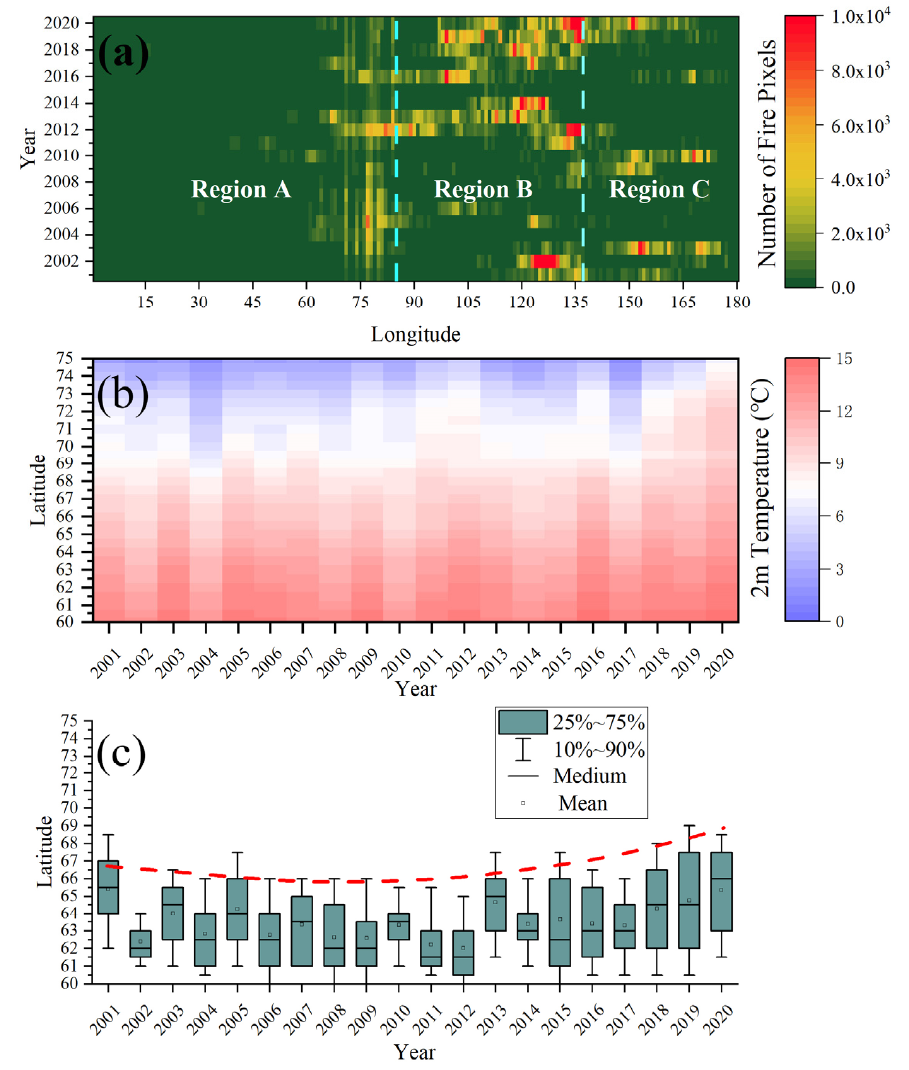
Figure 7. Summary trends in the spatial distribution of MCD14ML active fire pixels. ( a ) Longitude vs. time. ( b ) Latitude vs. time, for median summer temperature of air at 2 m above the surface (T2M) of land. ( c ) Boxplot for latitudinal distribution of fires over 20 years. Red dashed line indicates the second-order polynomial curve for whiskers representing 90% of the fire pixels for the specified year.